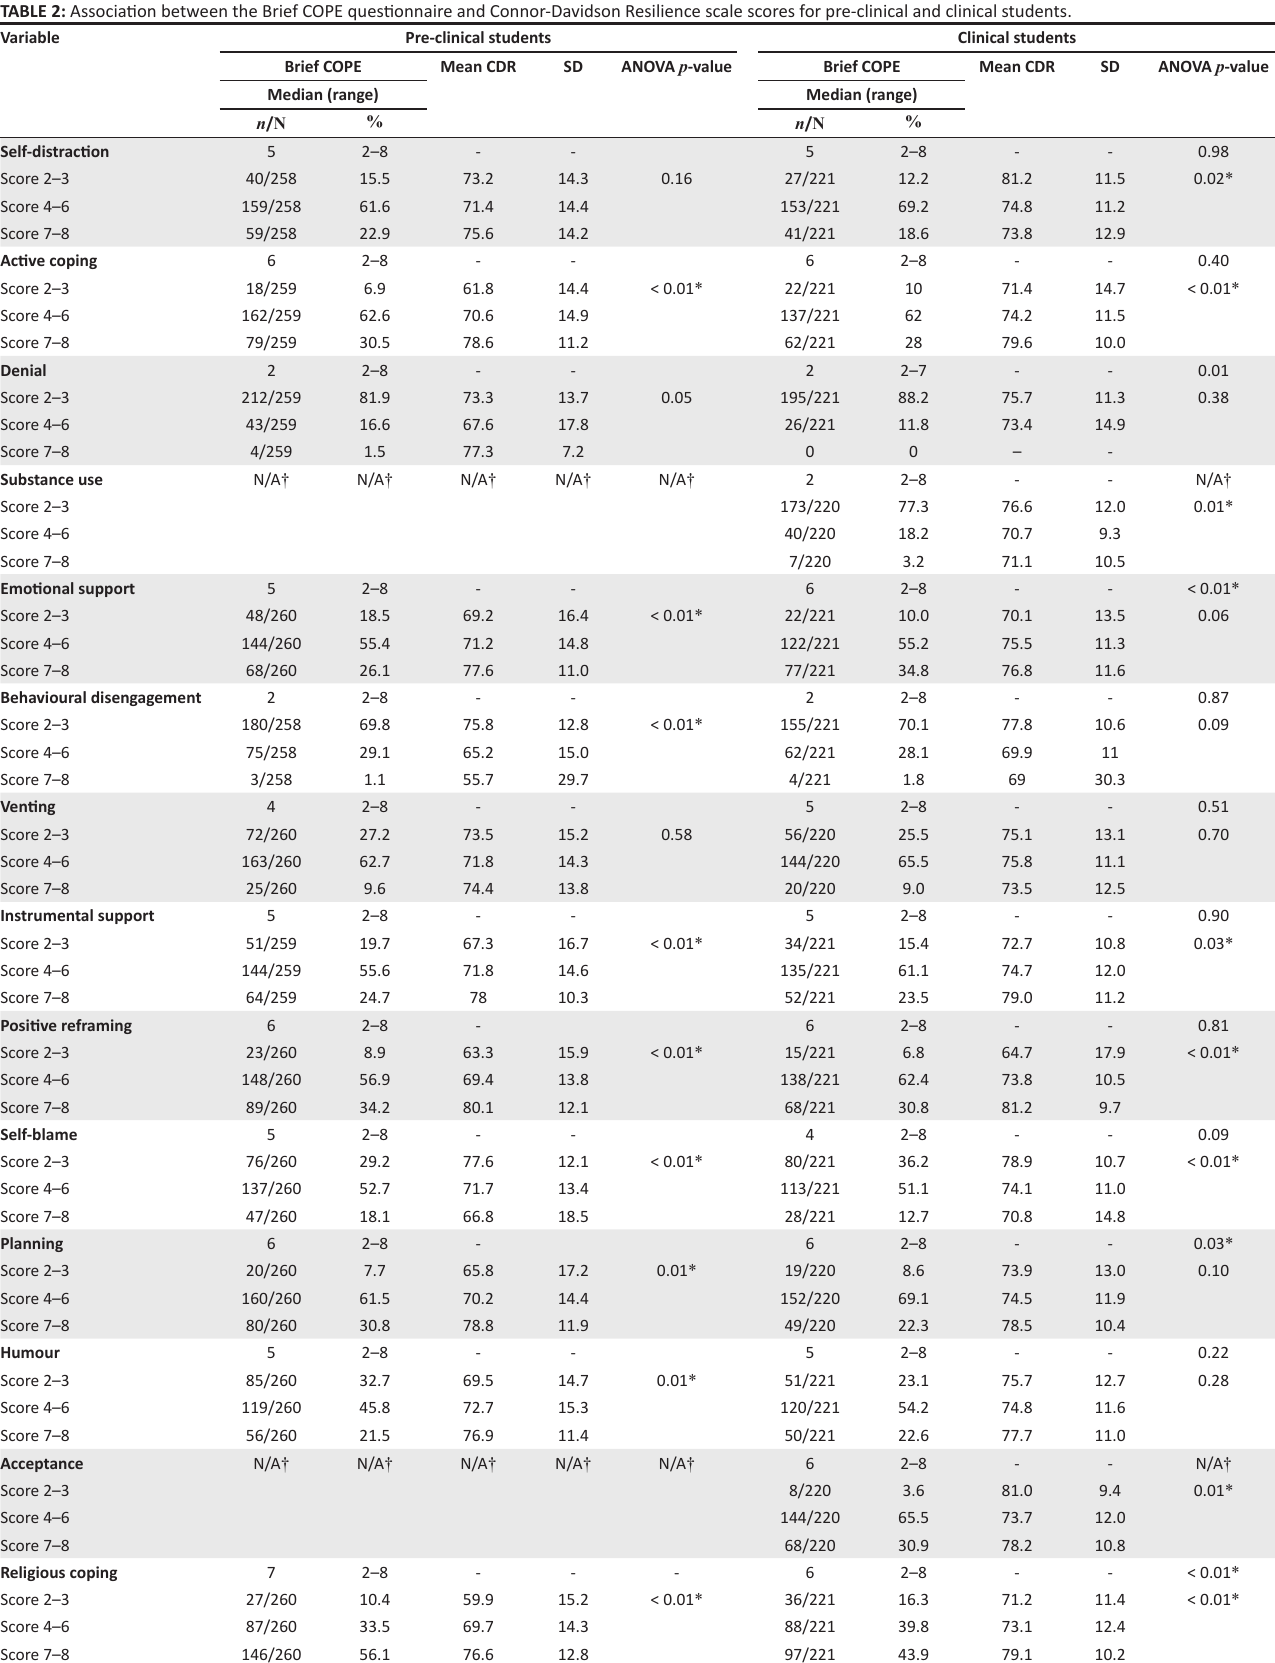
TABLE 2: Association between the Brief COPE questionnaire and Connor-Davidson Resilience scale scores for pre-clinical and clinical students.